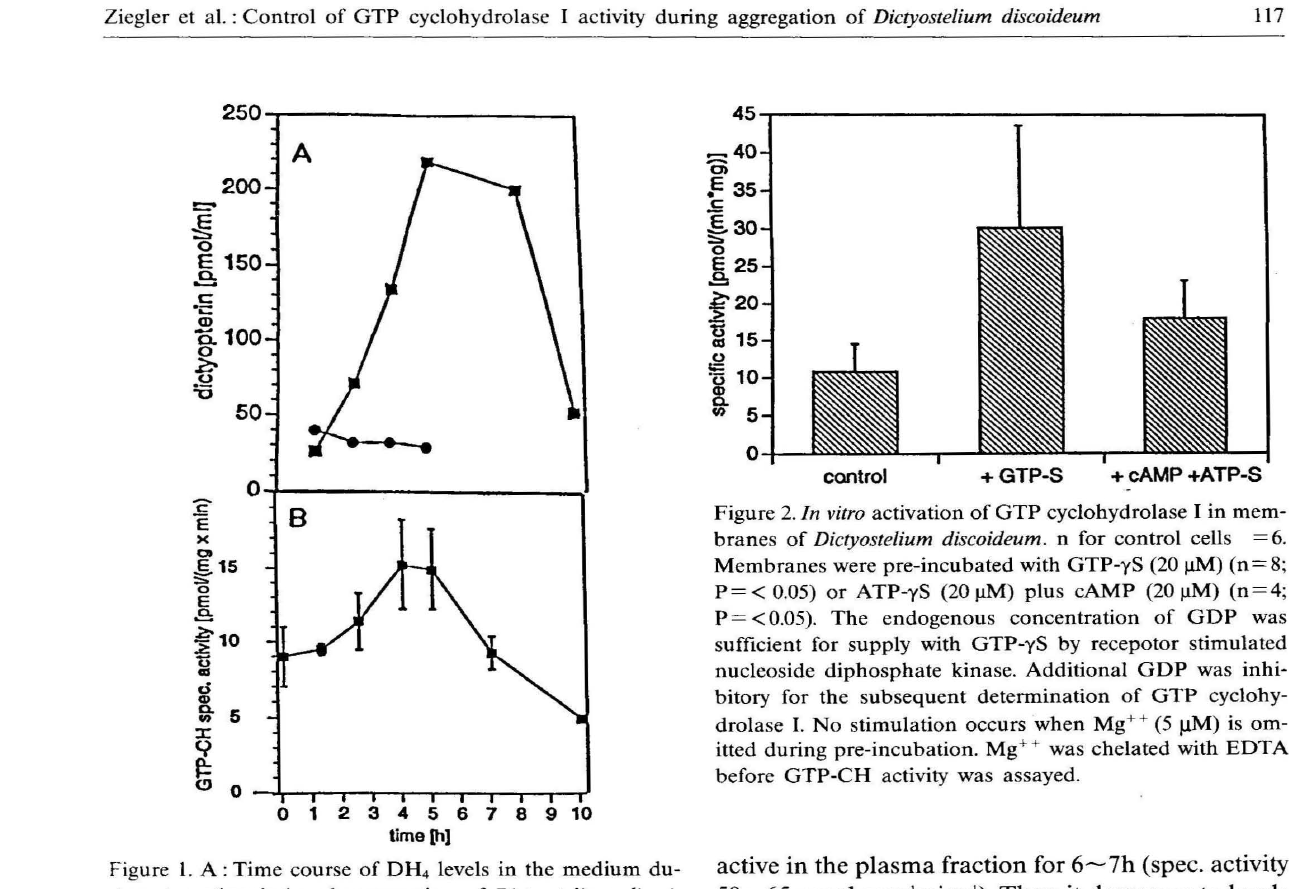
Figure 2. In vitro activation of GTP cyclohydrolase I in mem branes of Dictyostelium discoideum. n for control cells